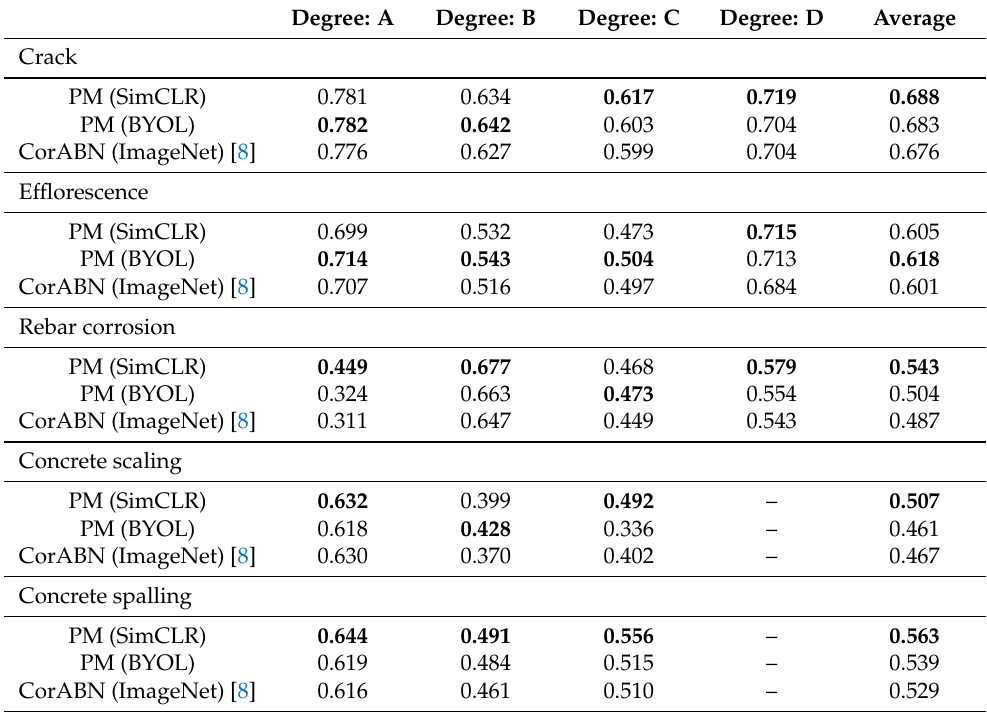
Table 12. F1-scores of PM using SimCLR and BYOL parameters and CorABN using ImageNet parameters. The best scores for each degree and the average are presented in